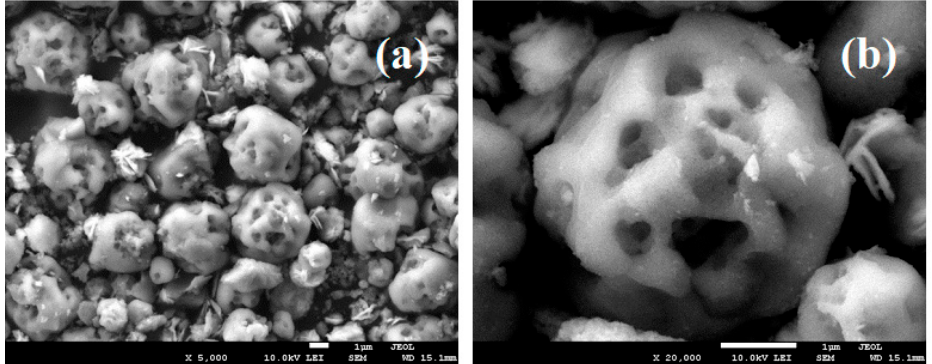
Figure 3. SEM images of CaCO 3 :Ce particles at the ( a ) low magnification; ( b ) high magnification.